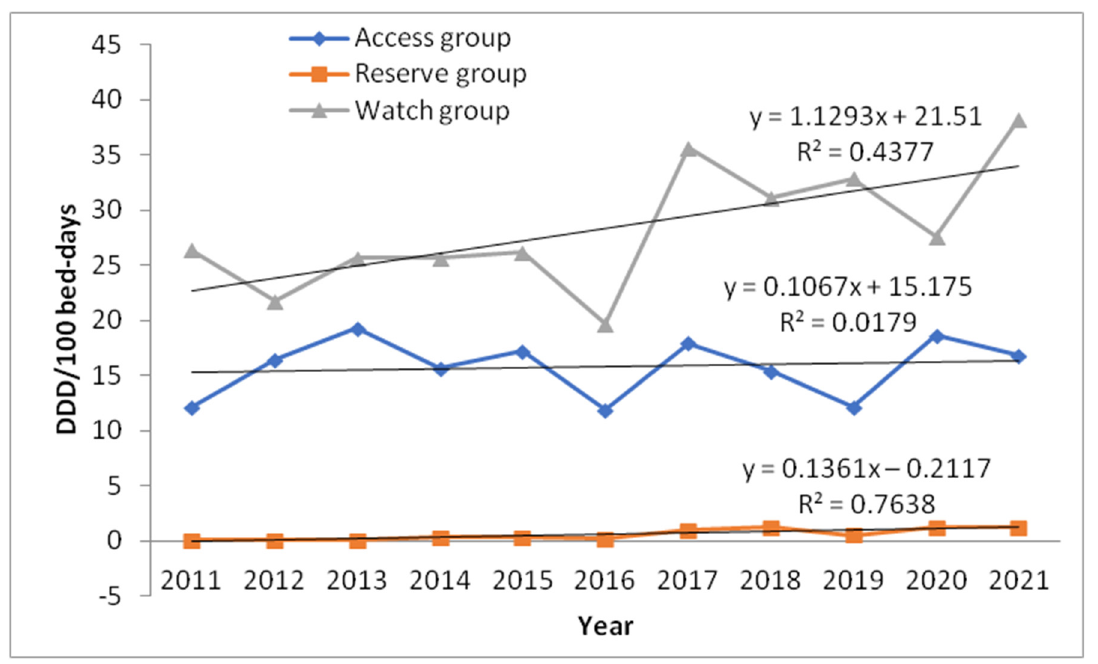
Figure 2. Trend of antibiotic consumption in defined daily doses (DDD) per 100 bed-days according to WHO Access, Watch, and Reserve Classification.